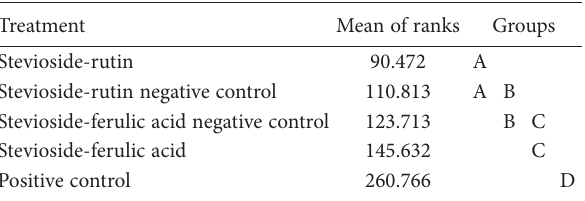
Table 4. Mean lengths of vascular necroses in grapevine plants after inoculations with Dothiorella viticola . Mean of rank values accom- panied by the same letters are not significantly different ( P < 0.05; Kruskal-Wallis test, and multiple pairwise comparisons using the Conover-Iman